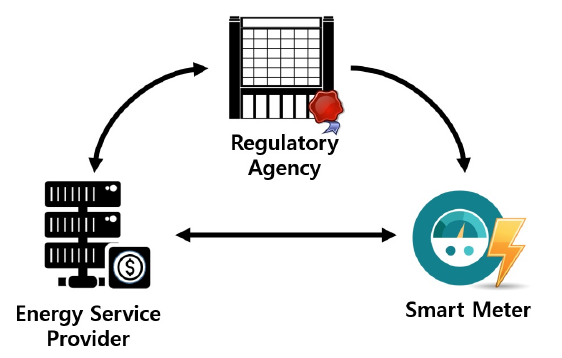
Figure 1. Proposed system